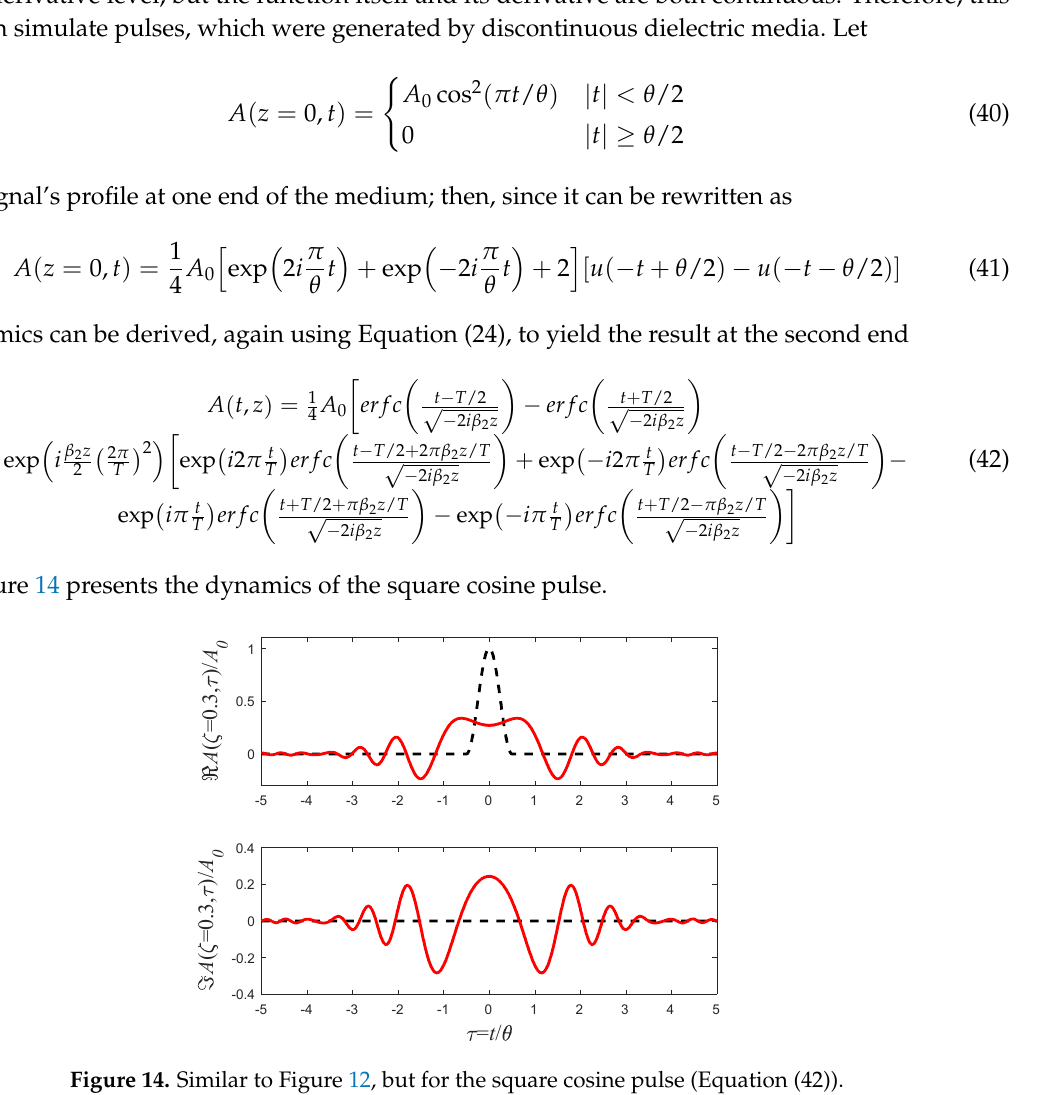
2 ) of the pulse presented by Equation (39).   2 , ztA ) of the pulse presented by Equation (39). Figure 13. Same as Figure 2, but for the intensity ( | A ( t , z ) |